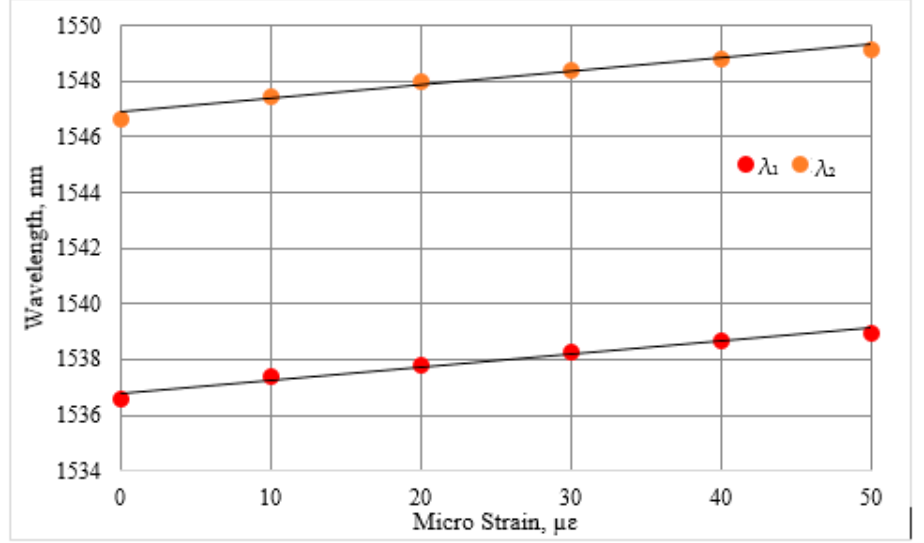
Figure 7. Wavelength shift of λ 1 and λ 2 as a function of strain.